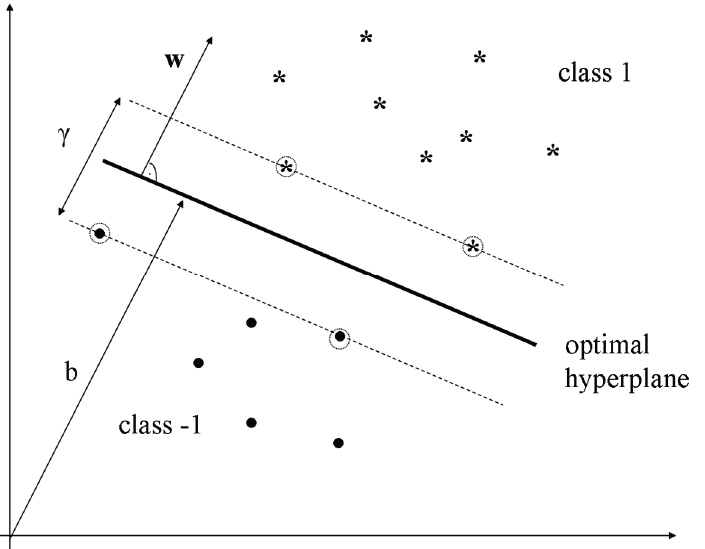
Figure 1. Hyperplane for binary